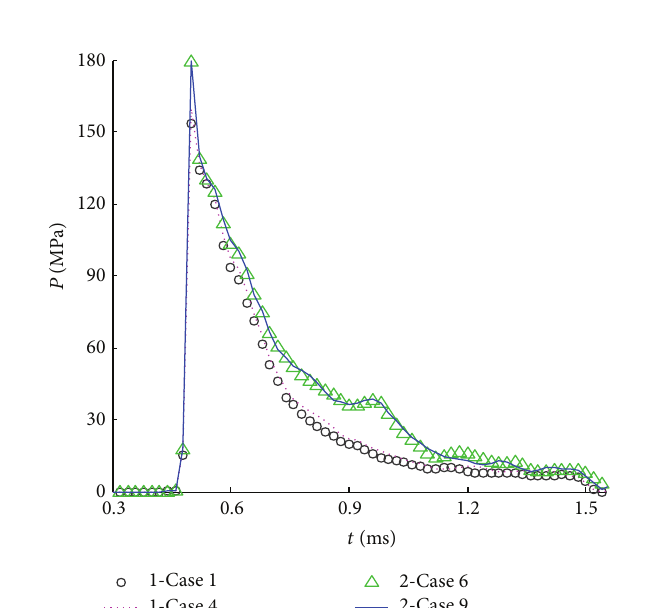
Figure 13: Pressure nephograms of double-hull.